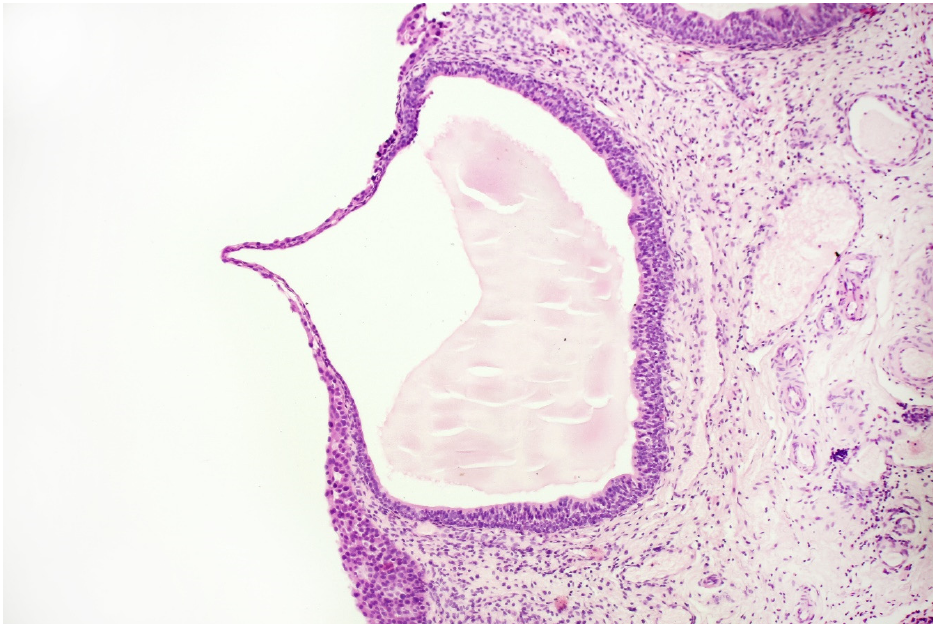
Figure 7. Histopathological specimen—Haematoxylin and Eosin (H&E) staining. Cystitis cystica. The cysts are filled with homogeneous eosinophilic fluid and lined with the urothelial epithelium, the cells of which do not show signs of atypia. The atypia is visible in the epithelium, lying on the surface of the bladder in the immediate vicinity of the described cystic structures, in the submucosa of the bladder. There is no crawling of the atypical epithelium into these cysts. J. Pers. Med. 2021 , 11 , x FOR PEER REVIEW